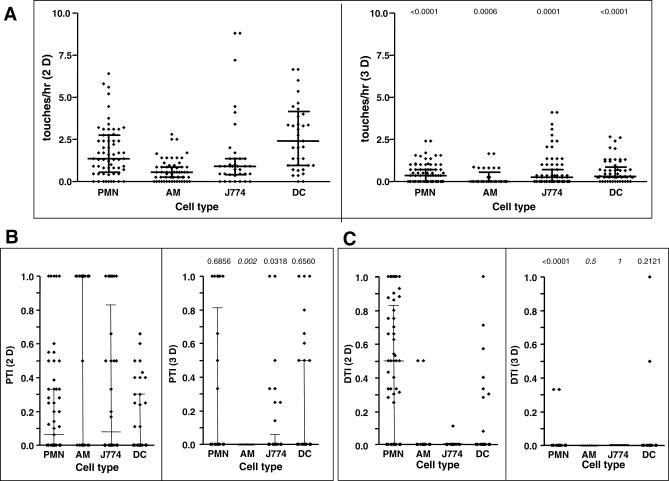
The Physical Interaction of A. fumigatus Conidia and Several Phagocytes Is Strongly Influenced by the Dimensionality of the Environment(A) Column scatter plots showing the number of contacts between phagocytes and conidia per hour in 2-D and 3-D environments. Each dot represents all observable contacts of an individual cell with conidia within a given video. As observation times for single cells vary greatly due to movements in and out of focus, values have been normalized on the average number of contacts per hour. Individual conidia touching cells as detected in (A) were subsequently followed for their fates. This could be simple release, dragging, or phagocytosis.Dots in (B) show the rate of conidia that have been successfully phagocytosed relative to the number of conidia that have been touched by a cell (PTI). Each dot represents the value for one single cell. All cell types have been investigated for their PTI in 2-D and in 3-D environments.(C) DTI values for the four cell types in 2-D and in 3-D environments. Evaluation of the DTI is analogous to the evaluation of the PTI with dragging as the physical interaction scored.Significance values (indicated over 3-D figures) have been obtained using the Mann-Whitney nonparametric U-test except where written in italics. Here the Mann-Whitney U-test was not applicable, and p-values were derived from the Wilcoxon rank sum test. Alternately, the Mann-Whitney U-test was performed after assigning arbitrary small values to the 0 entries. This yielded results similar to those of the Wilcoxon rank sum test (p-values not shown). The horizontal bars in each column scatter plot indicate median. The vertical lines represent interquartile ranges.